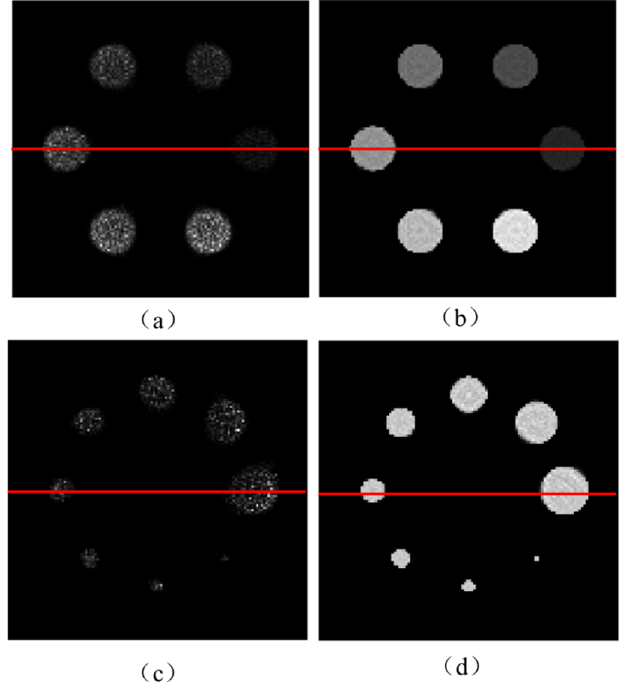
Figure 7. Profiles (red lines) and XFCT images of phantoms in numerical simulation. ( a , c ) reconstructed by MLEM without absorption correction, ( b , d ) reconstructed by MLEM with absorption